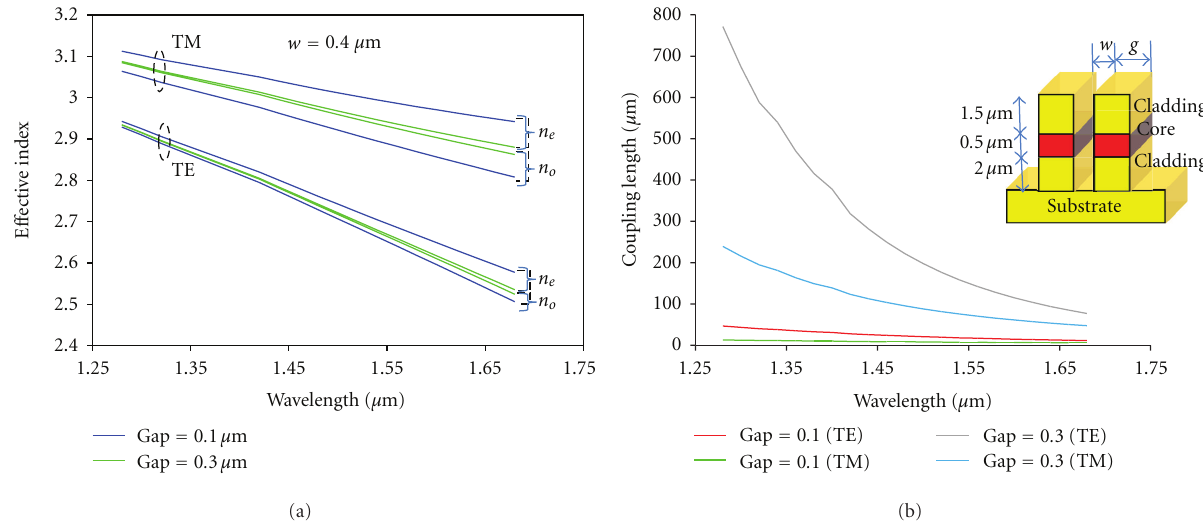
Figure 4: InP-based directional couplers: (a) e ff ective indices (for even and odd supermodes) and (b) coupling lengths, for both TE and TM as a function of gap size g (in μ m), with w = 0.4 μ m. Inset shows a schematic of the directional coupler.